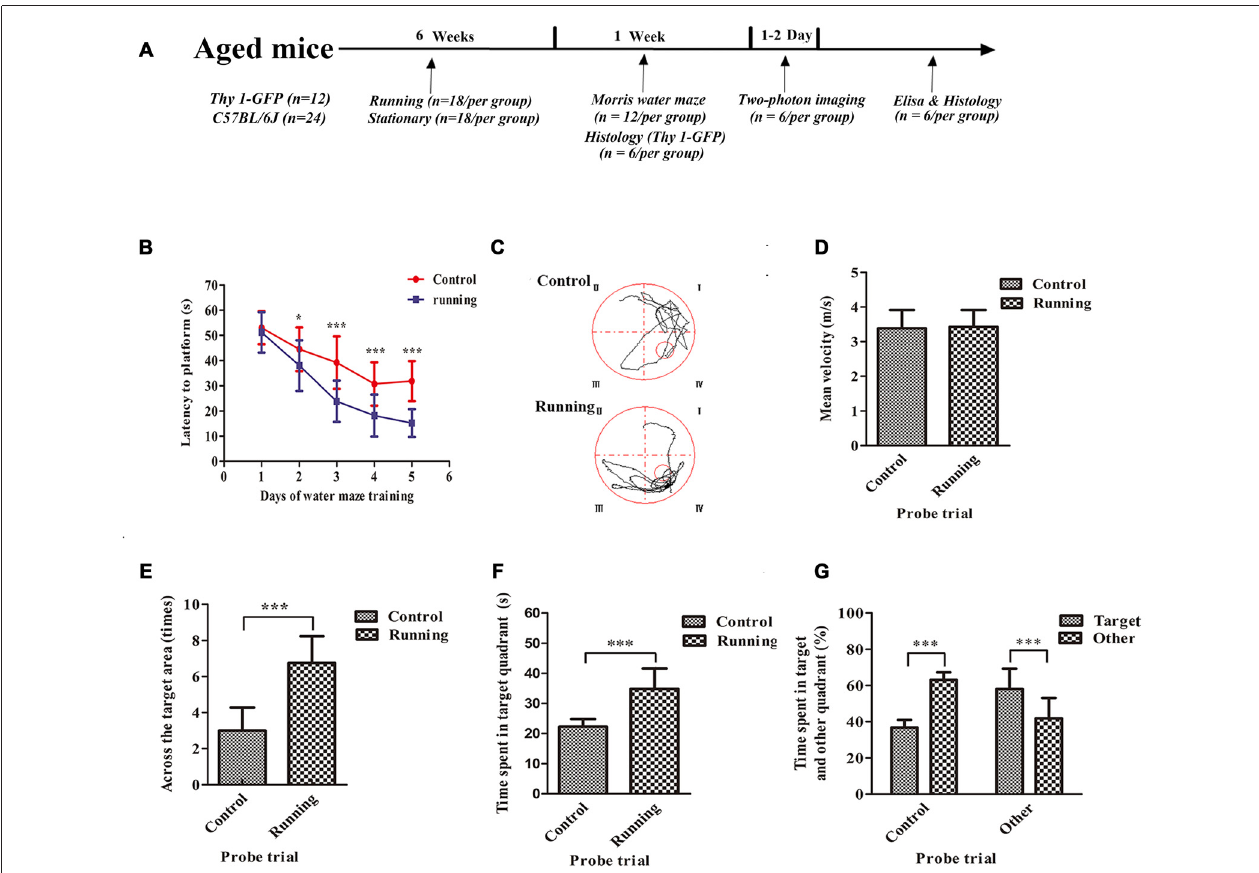
FIGURE 1 | Schematic diagram of the timeline of this study and the effects of voluntarily running on spatial memory in a water-maze task. (A) Timeline of the behavioral tests and biochemical parameters used in this study. (B) Time to reach the platform in the control and running groups during Morris water-maze training. (C) Representative swim paths of mice in the control and running groups during the probe trial. (D) Mean velocities of mice in the control and running groups during the probe trial. (E) Number of times the target area (former platform) was crossed in the control and running groups during the probe trial. (F,G) Time (F) and % time (G) spent in the target quadrant (formerly contained the platform) in the control and running groups during the probe trial. Datasets are expressed as means ± SD, n = 12. ∗ P ≤ 0.05; ∗∗∗ P ≤ 0.001.